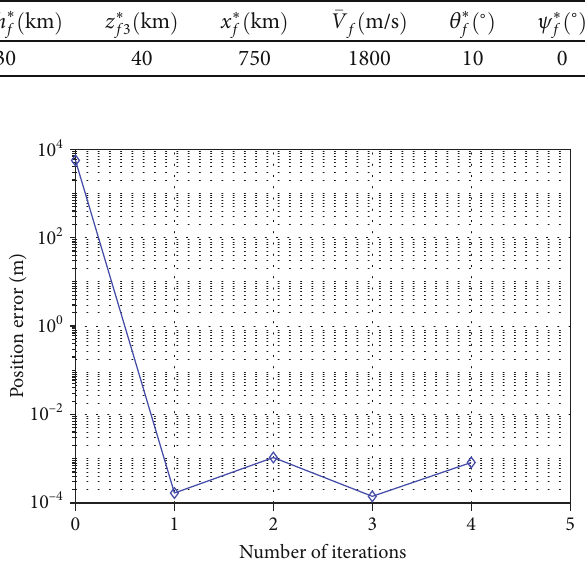
Figure 3: The error between the trajectory terminal position and the terminal position constraint.